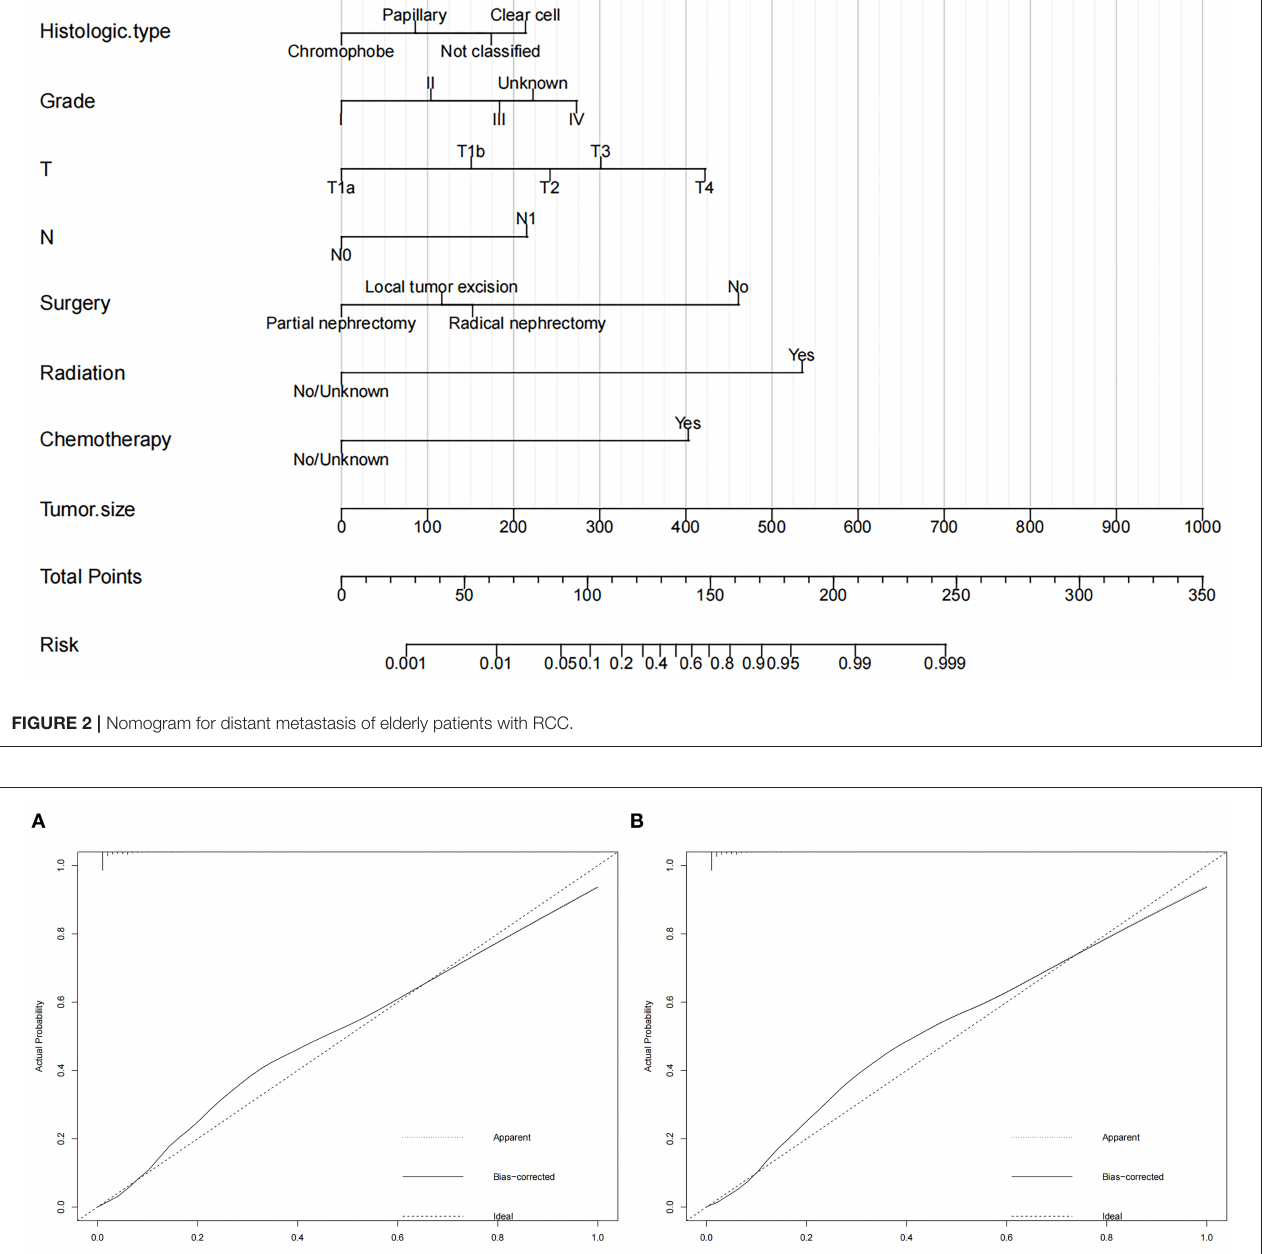
At present, it is very limited in predicting distant metastasis of RCC. Hutterer et al. (27) collected renal cell carcinoma patients in 12 medical centers and established rosettes to predict distant